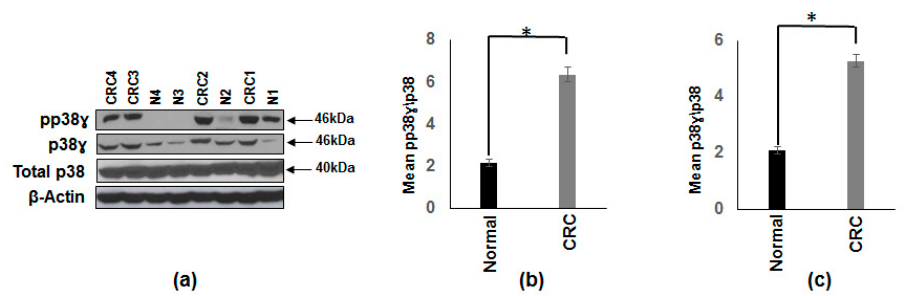
Figure 1. Increased protein expression and activation of p38 γ in human cancerous colonic tissue compared to normal subjects. ( a ) Whole tissue extracts from colon cancer patients and normal subjects were prepared and 25 µ g of protein subjected to SDS-gel electrophoresis and Western blot analysis using antibodies against p38 γ and pp38 γ . Equal loading was confirmed using an antibody against total p38 antibody. Representative blotting is shown for four normal (N) and four colon cancer (CRC) subjects. ( b ) Densitometric values expressed as fold increase of ratio of phosphorylated p38 γ / total p38. ( c ) Densitometric values expressed as fold increase of the ratio of p38 γ / total p38. The data was analyzed using the paired, two-tailed Student’s t -test, and the results were expressed as fold change ± SEM of 10 colon cancer patients and 10 normal subjects * p -value <